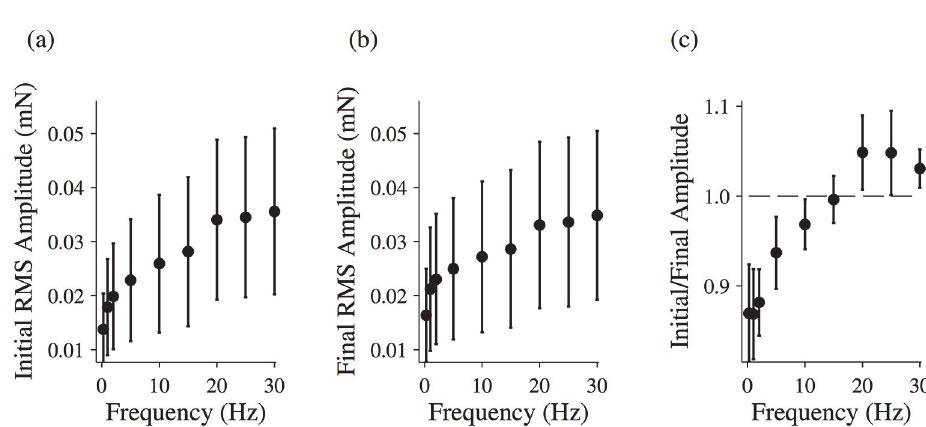
Fig 7. Changing force response for activated muscle fibers following treatment. The root-mean- squared (RMS) amplitude for the initial driving oscillation (a) and the final driving oscillation (b) for activated muscle fibers following treatment with EDTA and blebbistatin. (c) The ratio of the initial and final RMS amplitudes for activated muscle fibers following treatment with EDTA and blebbistatin. The total length of the oscillation was 20 seconds. All data points are (MEAN ± SEM), and the number of fibers analyzed was N =